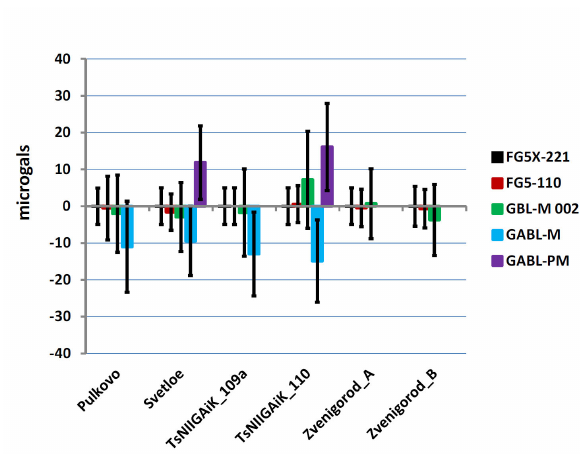
Figure 3: The station-by-station results of the RFCAG2013. The grav- ity values are shown with the result of the FG5X-221